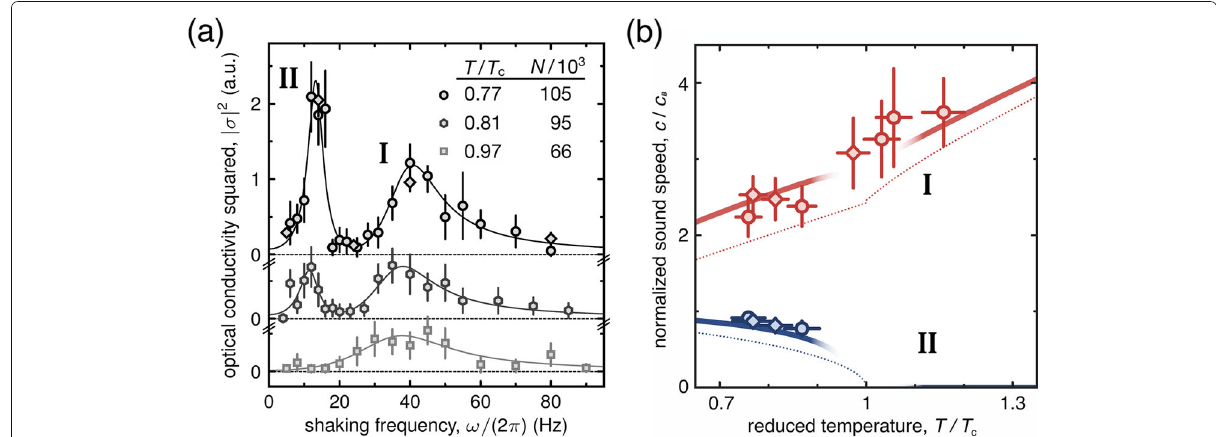
Fig. 18 a Optical conductivity squared | σ(ω) | 2 at three different reduced temperatures. The two peaks correspond to the two sound modes. The solid lines are fits using the sum of two resonances. b First (red) and second (blue) sound velocities, normalized by the Bogoliubov speed √ 4 π na (cid:2) / m , as a function of T / T c . The solid lines are the fit-free predictions of the two-fluid model, with n s calculated using the Popov c B = mean-field theory. The fade of the lines indicates the breakdown of the mean-field theory near T c . The dotted lines show the sound velocities calculated by using non-interacting equation of state and condensate density (as superfluid density). Adapted from Ref. [35]